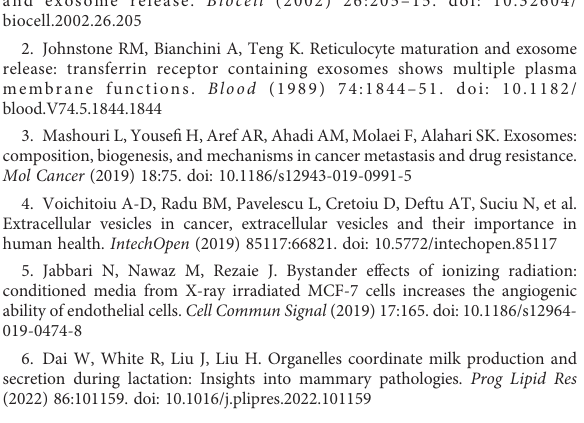
SUPPLEMENTARY FIGURE 1 Biogenesis of exosomes. Exosomes are generated from late endosomes, which are formed by inward budding of the limited multivesicular body (MVB) membrane. Invagination of the late endosomes forms intraluminal vesicles (ILVs) within MVBs, where certain molecules of the parental cells such as proteins and nucleic acids are incorporated into ILVs. While some ILVs are traf fi cked to lysosomes for degradation, most fuse with cell membrane and are released into the extracellular space, forming ‘ exosome ’ . SUPPLEMENTARY FIGURE 2 Illustrative diagram on human immune system and its key players. Human immune system is composed of ‘ innate immunity ’ and ‘ adaptive immunity ’ , where the latter is divided into ‘ cell-mediated immunity ’ and ‘ humoral immunity ’ . Dendritic cells (DCs), macrophages and B cells are professional antigen presentation cells (APCs). During innate immune response, DCs can directly kill pathogens, infected or malignant cells, activate NK cells to aid in the killing process, and present foreign antigens to T cells to stimulate cell-mediated immune response; NK cells, once activated by DCs, can kill pathogens, infected or malignant cells directly, and activate macrophages; macrophages can directly kill pathogens, infected or malignant cells directly, and present foreign antigens to T cells. Innate immune response also involves other participants such as mast cells, basophils, eosinophils, neutrophils and complements. During cell-mediated immune response, T cells, on receival of antigens presented by DCs, macrophages and B cells, are ampli fi ed and kill infected or malignant cells by producing perforin (protein that forms pore on targeted cells). During humoral immunity, B cells recognize pathogens, amplify and secrete antibodies to kill them. On recognition of pathogens, infected or malignant cells, innate immune response is activated fi rst (within 12h) followed by adaptive immune response (within days and can last weeks or even longer). Both innate and adaptive immune responses are fi rstly pro-in fl ammative (highest at 1-3h in innate immunity and 1-2d in adaptive immunity) and then anti-in fl ammative (highest at 6-12h in innate immunity and days in adaptive